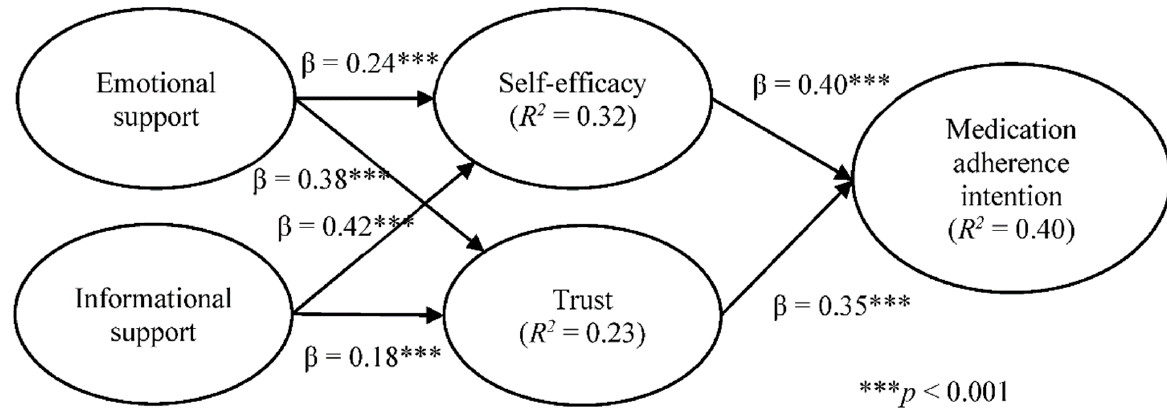
Figure 2. Structural model results.